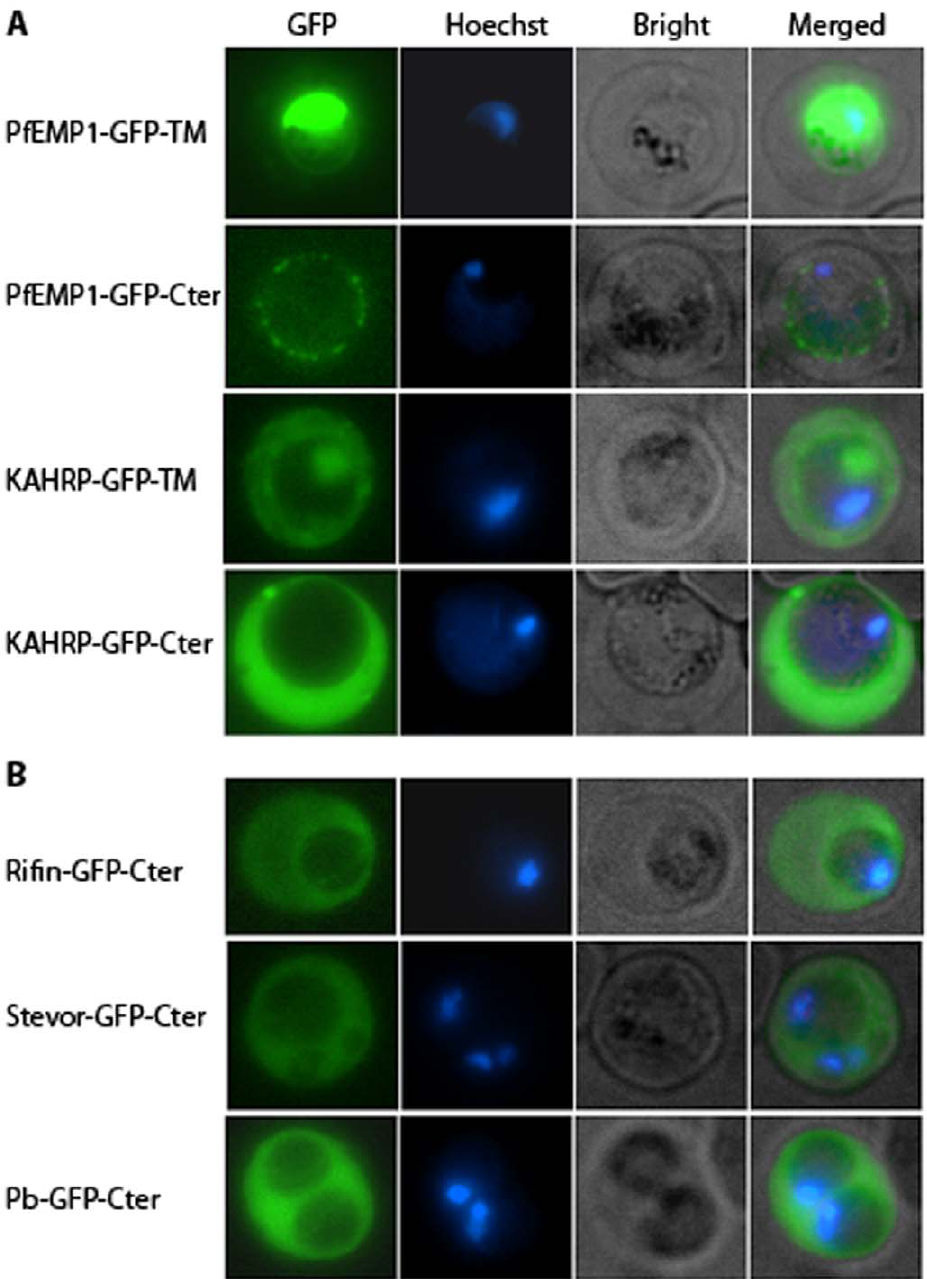
Figure 4. The C-terminus of PfEMP1 did not affect GFP export. Trophozoite-stage parasites were imaged as described for Fig. 2. ( A ) Parasites expressing GFP chimeras containing the N-terminus of PfEMP1 or KAHRP and the transmembrane domain or the C-terminus of PfEMP1 (PfEMP1-GFP- TM, KAHRP-GFP-TM, PfEMP1-GFP-Cter, KAHRP-GFP-Cter). ( B ) Parasites expressing GFP chimeras containing the C-terminus of PfEMP1 at the carboxy- terminus and N-terminus of rifin (Rifin-GFP-Cter), stevor (Stevor-GFP-Cter), and a predicted P. berghei exported protein (Pb-GFP-Cter) at the N- terminus were imaged.